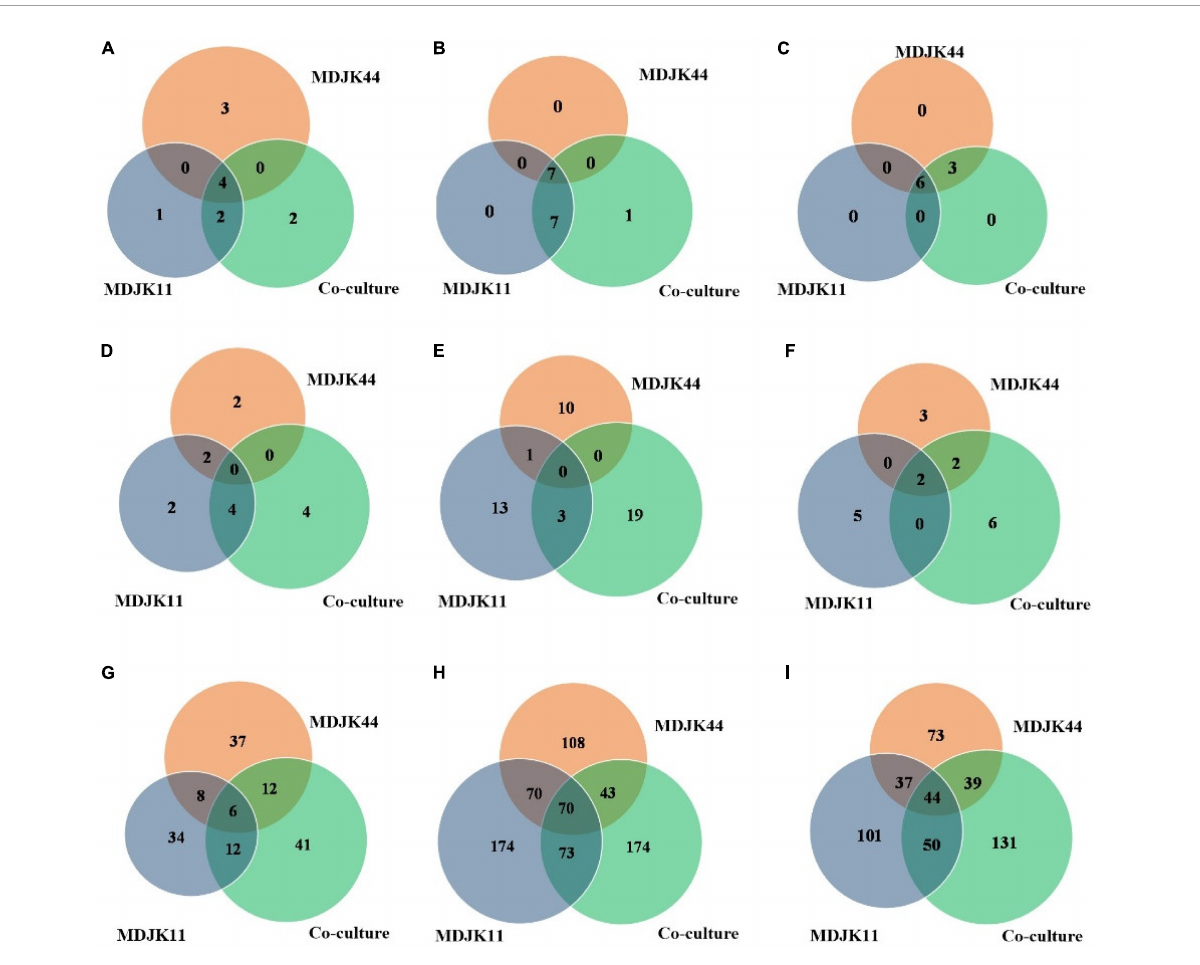
FIGURE10 Statistical Venn diagrams for different identified metabolites of Streptomyces MDJK11 and MDJK44 in monoculture and co-culture [ (A) , plant hormones; (B) , coumarin; (C) , phenolic acid; (D) , aminoglycosides; (E) , macrolides; (F) , cyclic peptides; (G) , alkaloid; (H) , terpenoids; and (I) ,